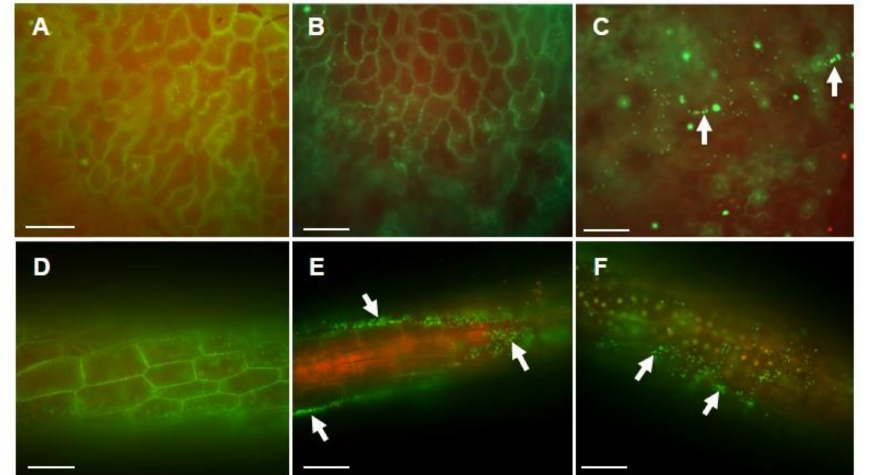
Figure 4. Fluorescent micrographs of live/dead stained fronds ( A – C ) and roots ( D – F ) of aseptic L. aequinoctialis ( A , D ) and of L. aequinoctialis co-cultured with the F-183 ( B , E ) and TBR-22 ( C , F ) strains. Live and dead cells are visualized in green and red, respectively. Arrows indicate examples of live stained cells. Bars, 50 µ m.